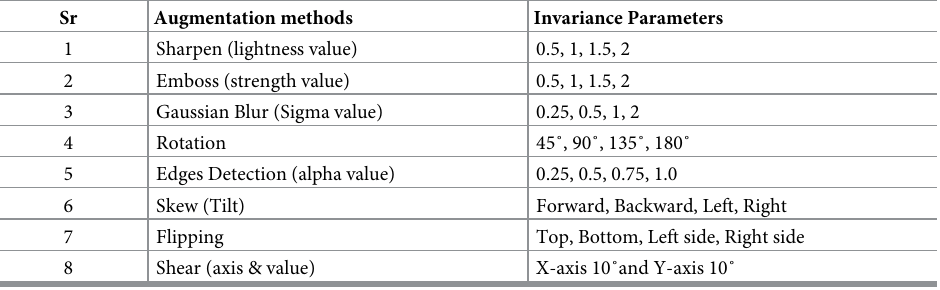
Table 1. Different ques of augmenting data with invariance